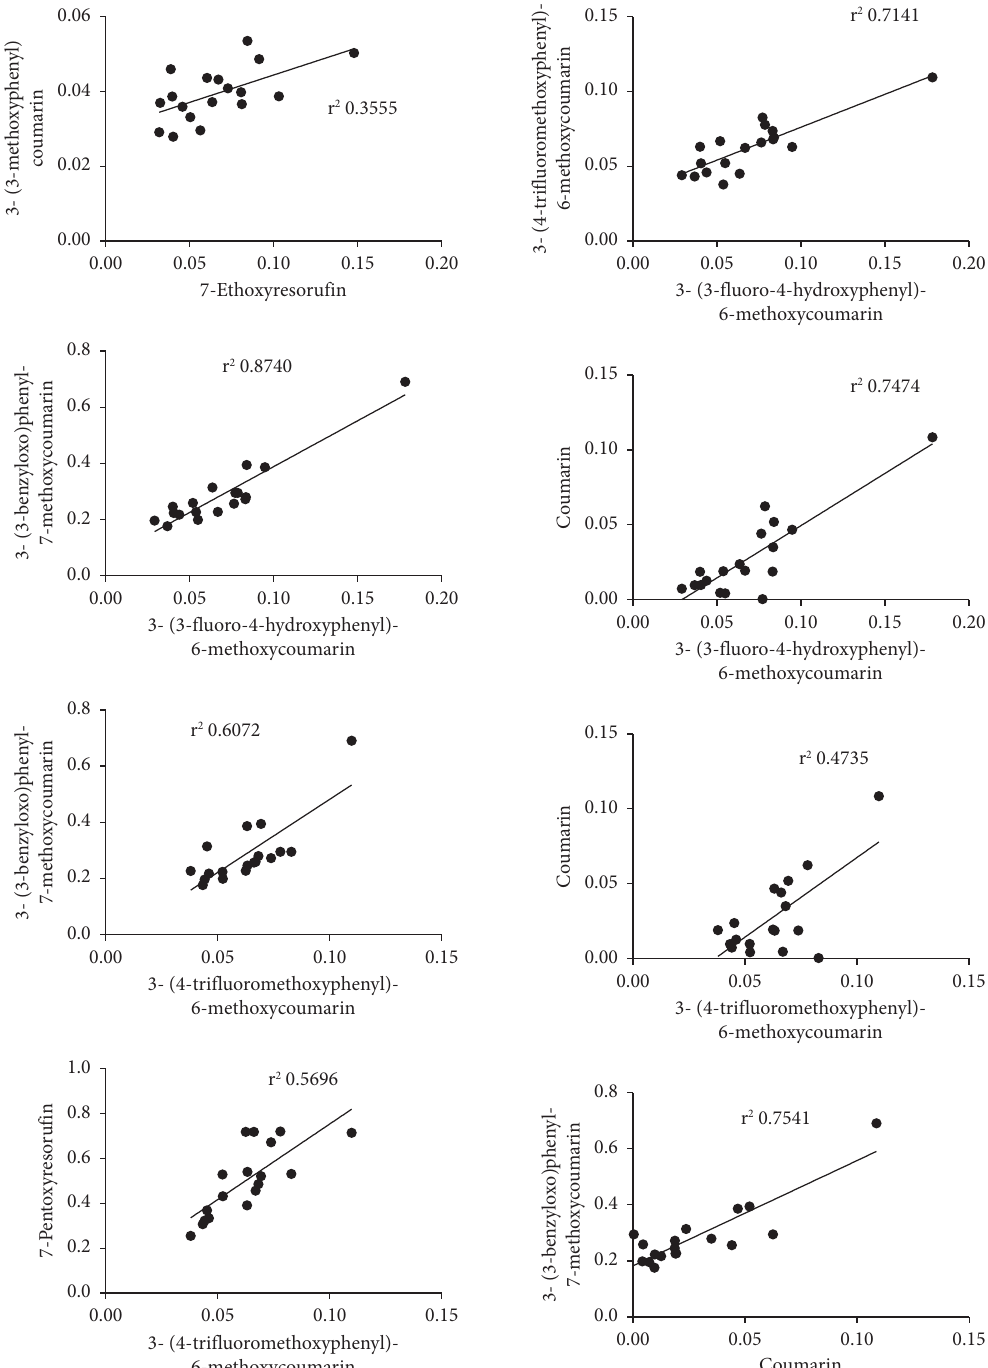
Figure 5: Statistically signifcant linear correlations between the oxidation rates of two probe substrates in liver microsomes in Figure 2 and Table